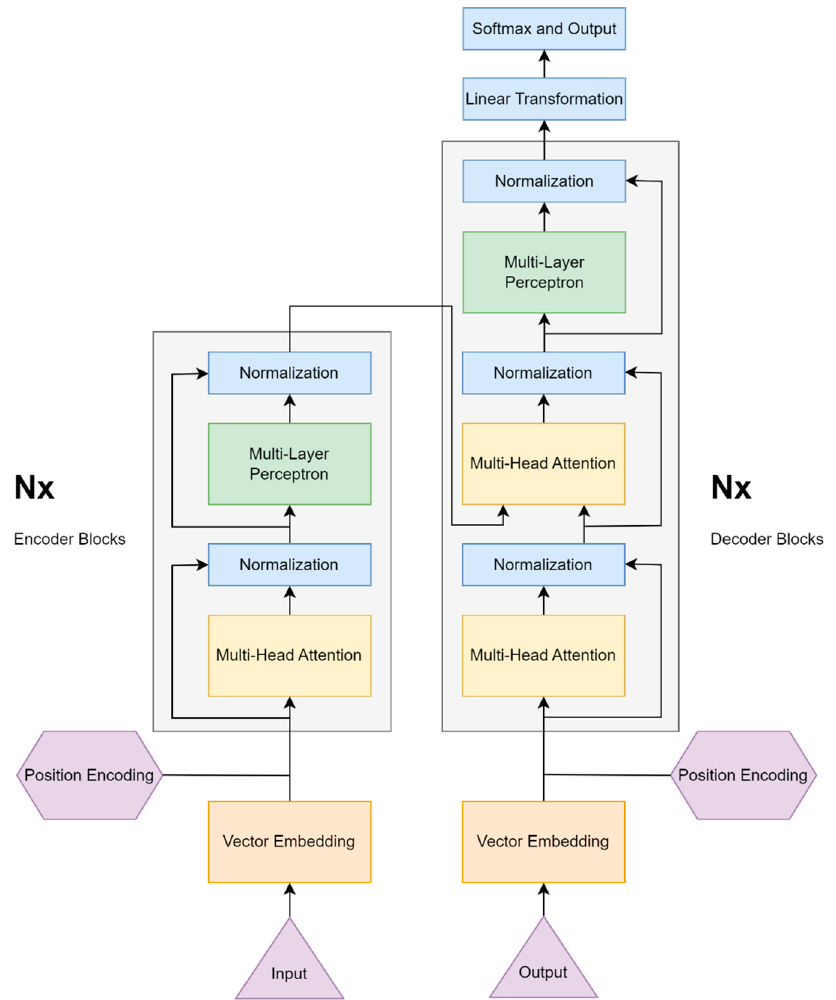
Figure 2. The Transformer architecture.